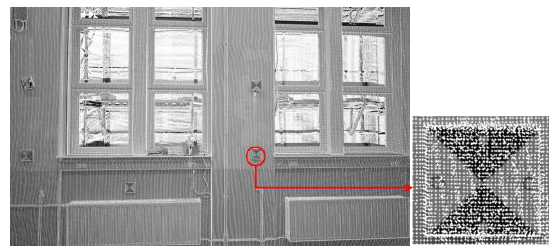
Figure 8. Re-projection of downsampled point clouds into the